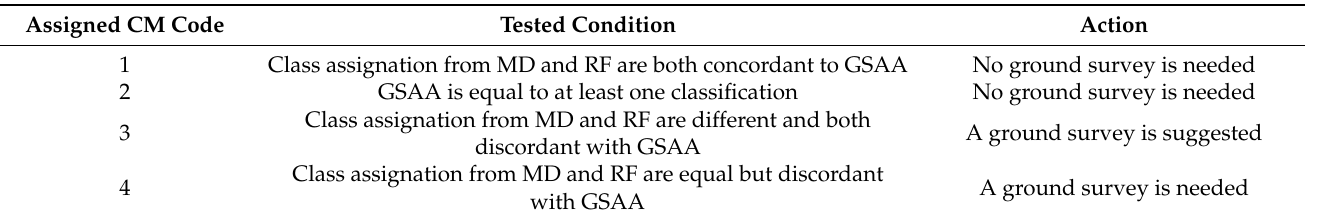
Table 7. Tested conditions and actions that the control system operates with respect to Minimum Distance (MD) and Random Forest (RF) classification